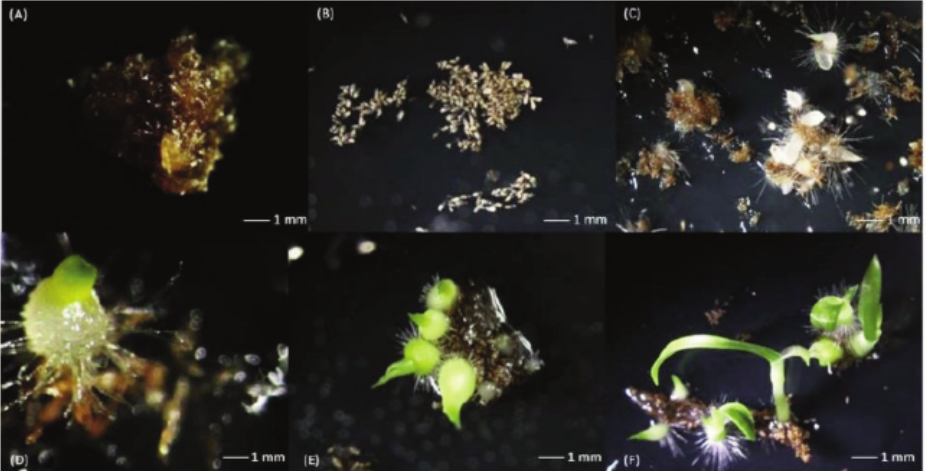
Fig. 2 ­ Seed development of Habenaria radiate × Habenaria rhodocheila on MM medium. (A) Sown seeds (day 0), (B) Protocorm deve­ lopment (50 days), (C) Enlarged embryo rupture testa and developed protocorm (3 months), (D) Green protocorm with protome­ ristem (3 months), (E) Emergence of first leaf (4 month), (F) Plantlets (5 months).